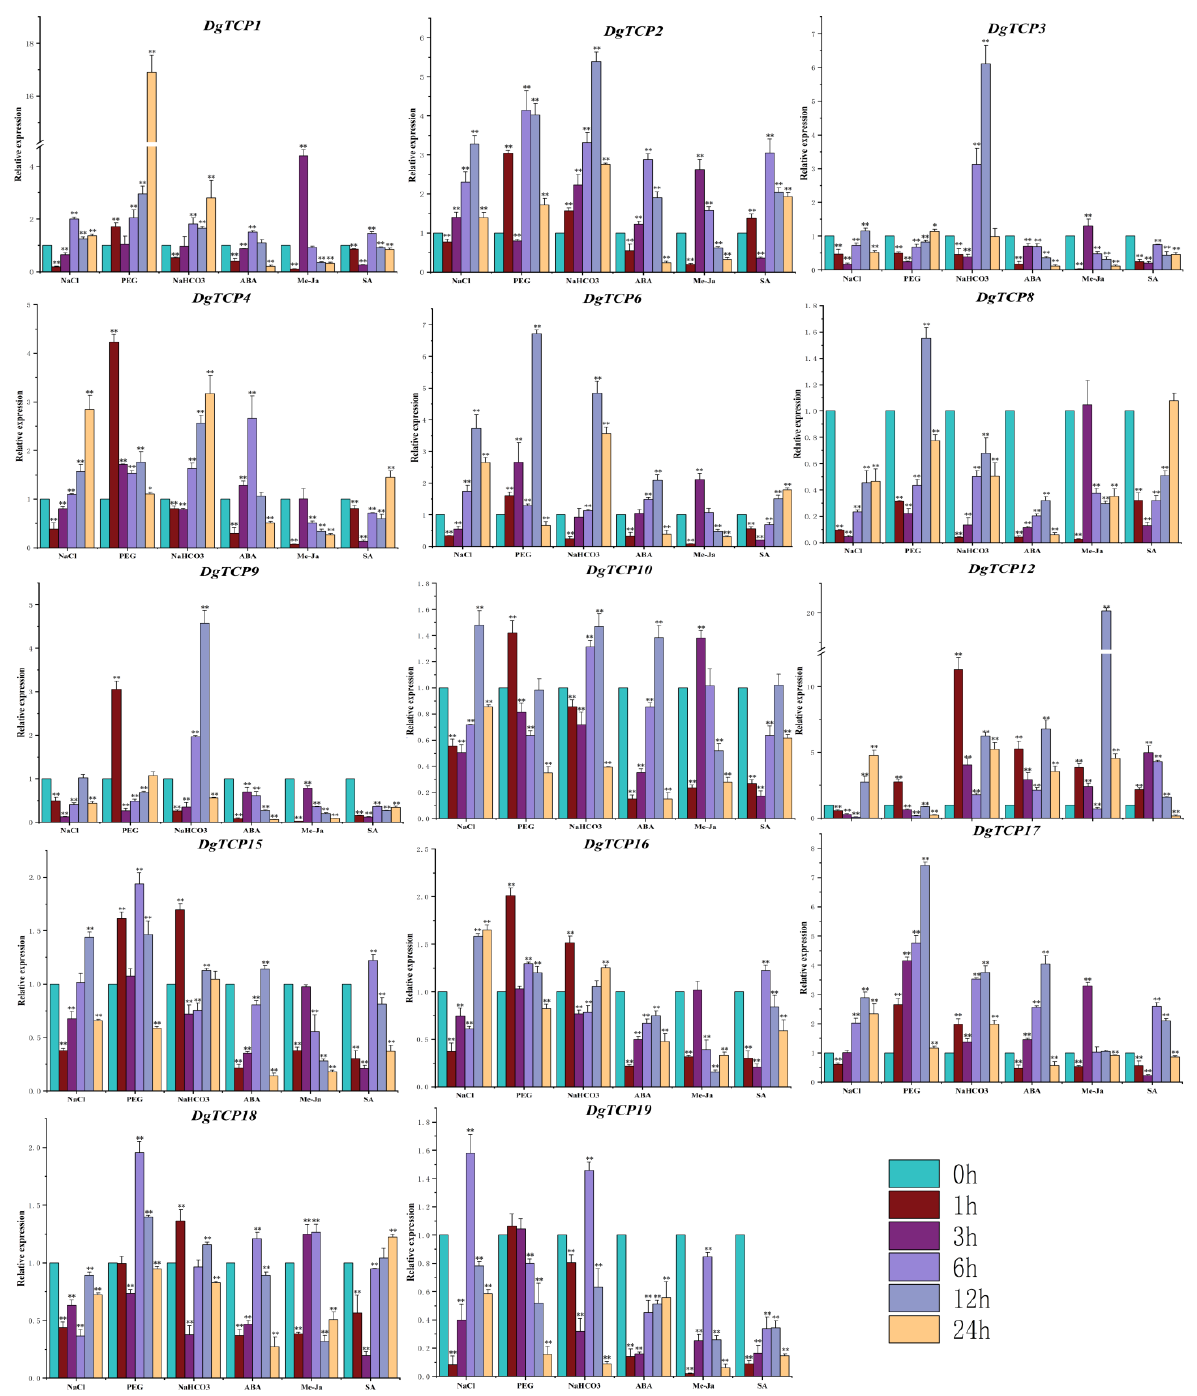
Figure 10. The expression of 14 DgTCP genes under drought (PEG), salt (NaCl), alkali (NaHCO 3 ), ABA, Me-JA, and SA treatment by qRT-PCR. The error bars show the standard deviations of the three biological replicates. ** , p < 0.01 and * , p < 0.05 show the significance of the differences between the control and treatment groups.